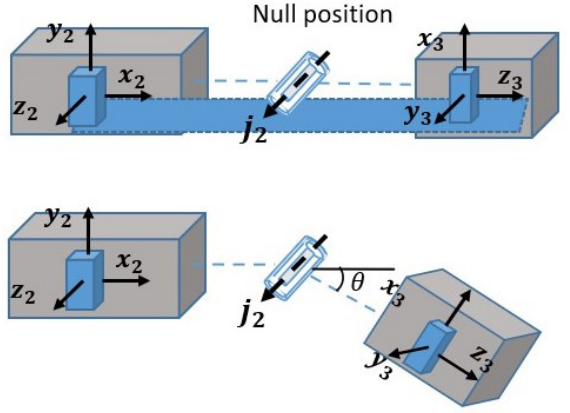
Figure 5. The schematic diagram of the rotational relationship around the axis j 2 of the